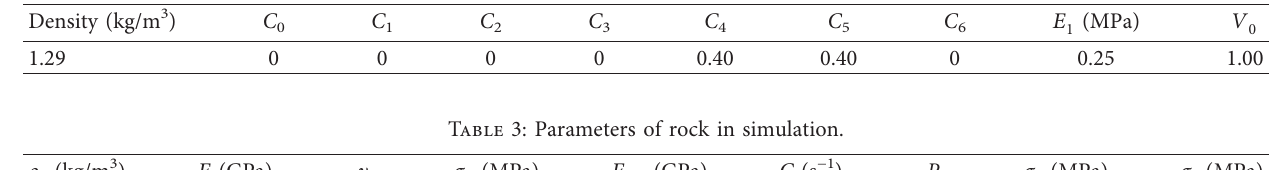
Table 2: Parameters of air in simulation.